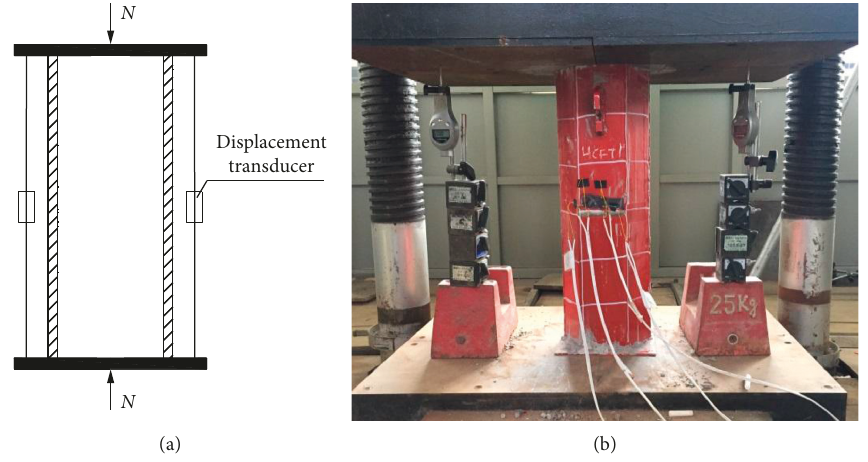
Figure 3: Sketch for testing the apparatus of CFST stub column. (a) Test setup. (b) Loading device.